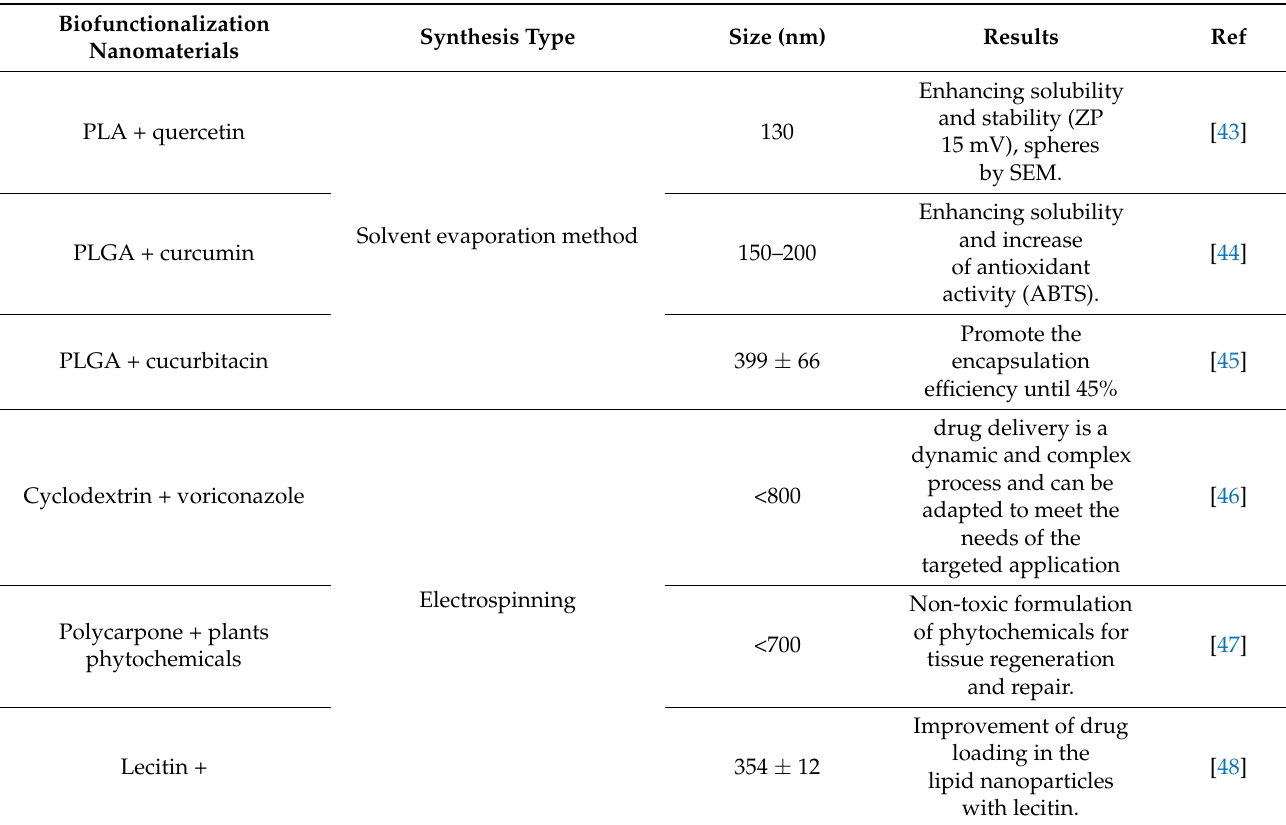
Table 2. Biofunctionalized compounds by solvent evaporation method and